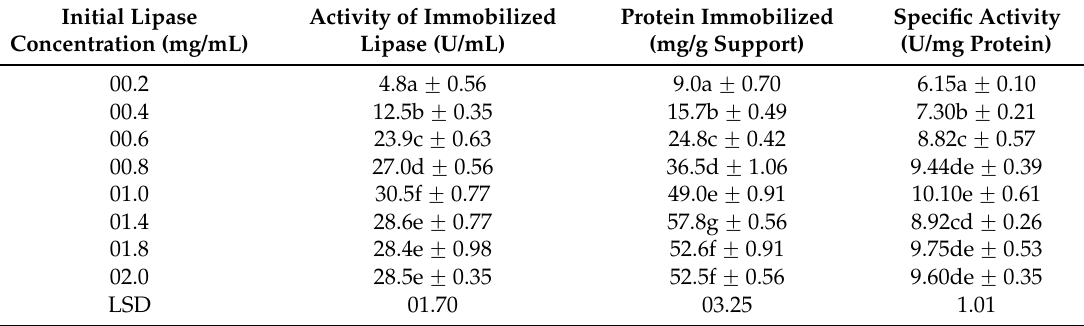
Initial Lipase Concentration